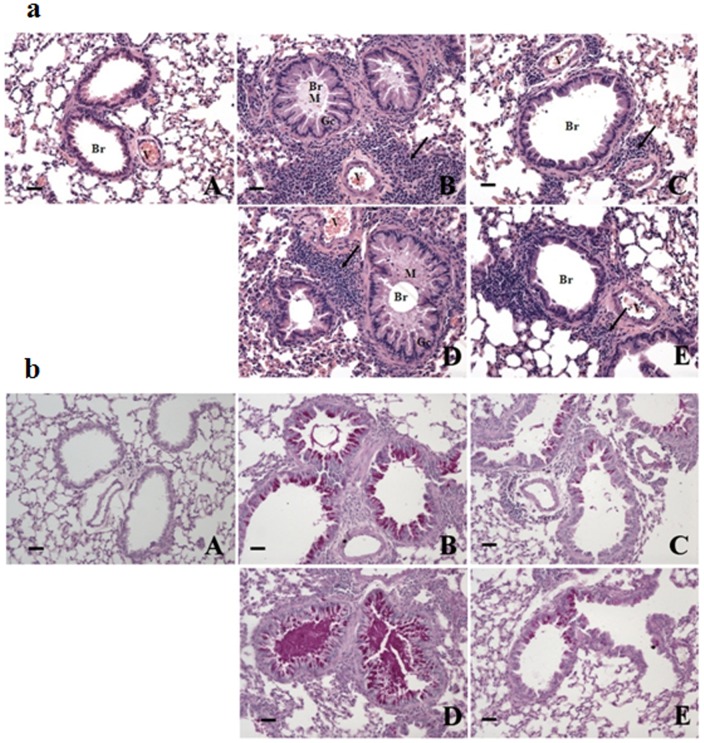
ACA dose-dependently inhibited histopathological changes in the lungs of mice with OVA-induced asthma.(a) ACA dose-dependently reduced inflammatory cell infiltration around vessels and bronchioles, mucus secretion and cell debris in bronchioles, and goblet cell hyperplasia in the lungs. Bar size, 50 μm; hematoxylin and eosin stain. (b) ACA dose-dependently decreased bronchial secretion of glycoproteins in OVA-induced asthma. Bar size, 50 μm; PAS stain. Arrow: inflammatory cell infiltration. Br, bronchiole; Gc, goblet cell; M, mucus secretion; V, vessel. A, vehicle control; B, OVA-induced asthma model; C, dexamethasone; D, 25 mg/kg/day ACA; E, 50 mg/kg/day ACA.